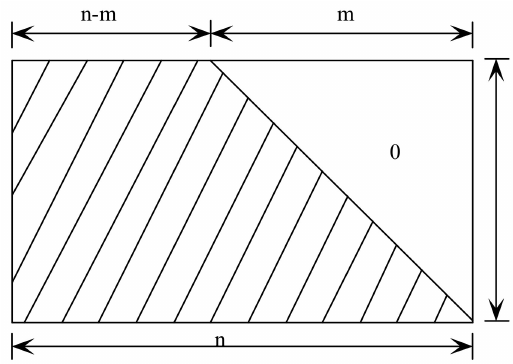
Figure 2. Check matrix with lower triangle